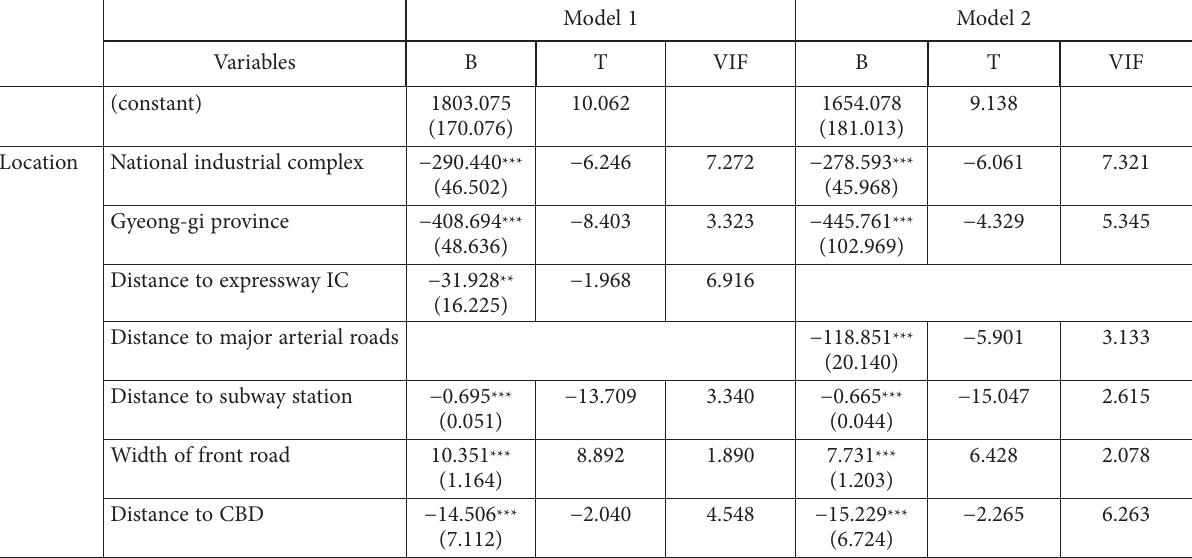
Table 7. Results of regression